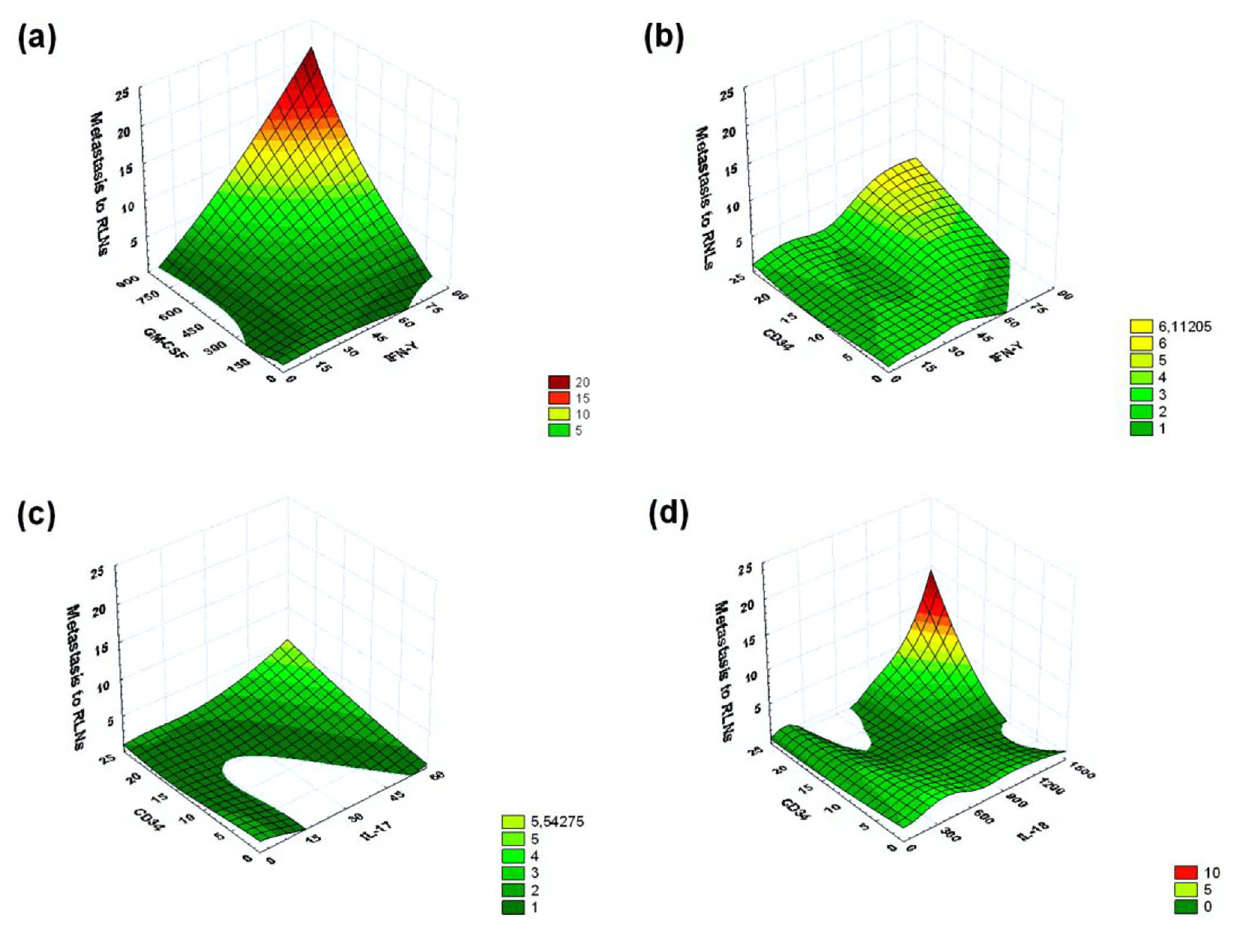
Figure 4. By means of a 3D surface plot (negative exponential smoothing), a 3D distribution surface was built that characterizes the dependence of the number of detected RLNs with metastases on concentrations of the pair of cytokines (pg/ml) produced by cultured IC-NST samples, and concentrations of different cytokines (pg/ ml) and expression of the CD34 differentiation cluster in IC-NST samples. ( a ) The dependence of the number of detected RLNs with metastases on concentrations of IFN-γ and GM-CSF produced by IC-NST samples. ( b ) The dependence of the number of detected RLNs with metastases on concentrations of IFN-γ produced by IC-NST samples and indicators of CD34 expression in IC-NST samples. ( c ) The dependence of the number of detected RLNs with metastases on concentrations of IL-17 produced by IC-NST samples and indicators of CD34 expression in IC-NST samples. ( d ) The dependence of the number of detected RLNs with metastases on concentrations of IL-18 and indicators of CD34 expression in IC-NST